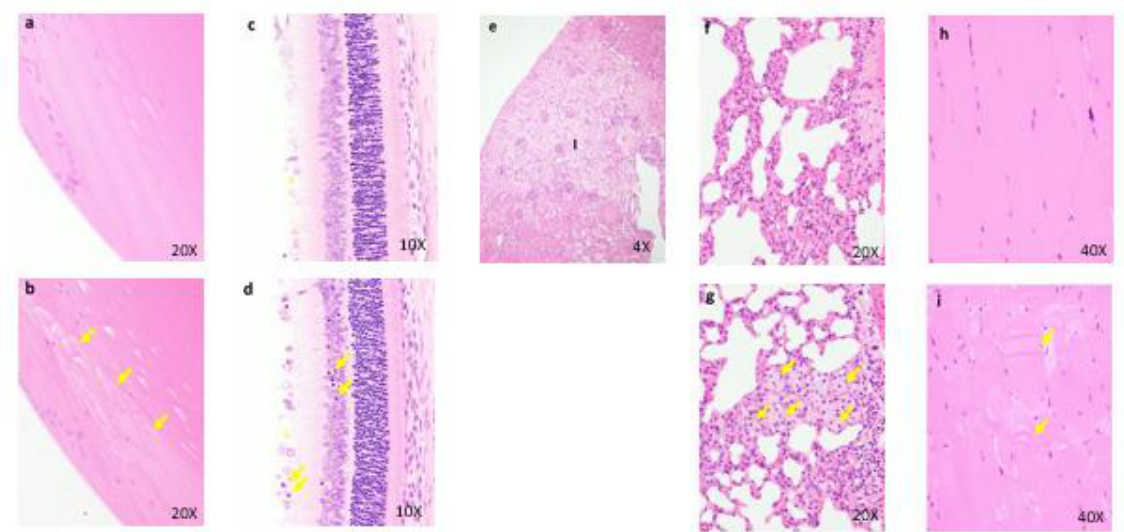
Figure 2: Histopathological findings in lens. control (a), 300 mg/kg (b), a , No abnormalities detected. b , Degeneration of lens fibers (arrows) are seen. Histopathological findings in retina. control (c), 300 mg/kg (d), c , No abnormalities detected. d , Apoptotic cells (arrows) are seen. Histopathological findings in kidney ( e ), 300 mg/kg, The infarction (I) is seen. Necrosis and inflammatory cells infiltration in the le- sions. Histopathological findings in lung. control (f), 300 mg/kg (g), f , No abnormalities detected. g , Many foamy cells ( arrows ) are seen. Histopathological findings in skeletal muscle. control (h), 300 mg/kg (i), h , No abnormalities detected. i , Degeneration/necrosis of muscle fibers (arrows) are